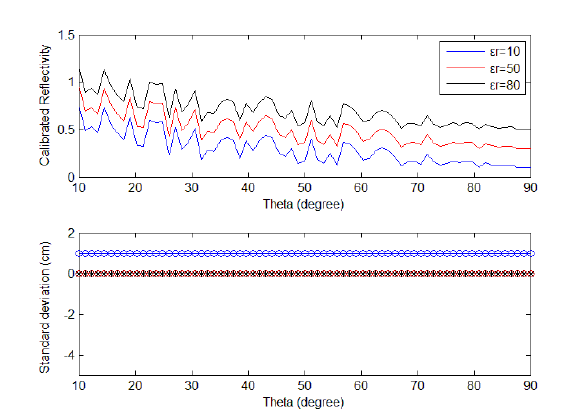
Fig. 4. The estimation of soil surface roughness for random surface